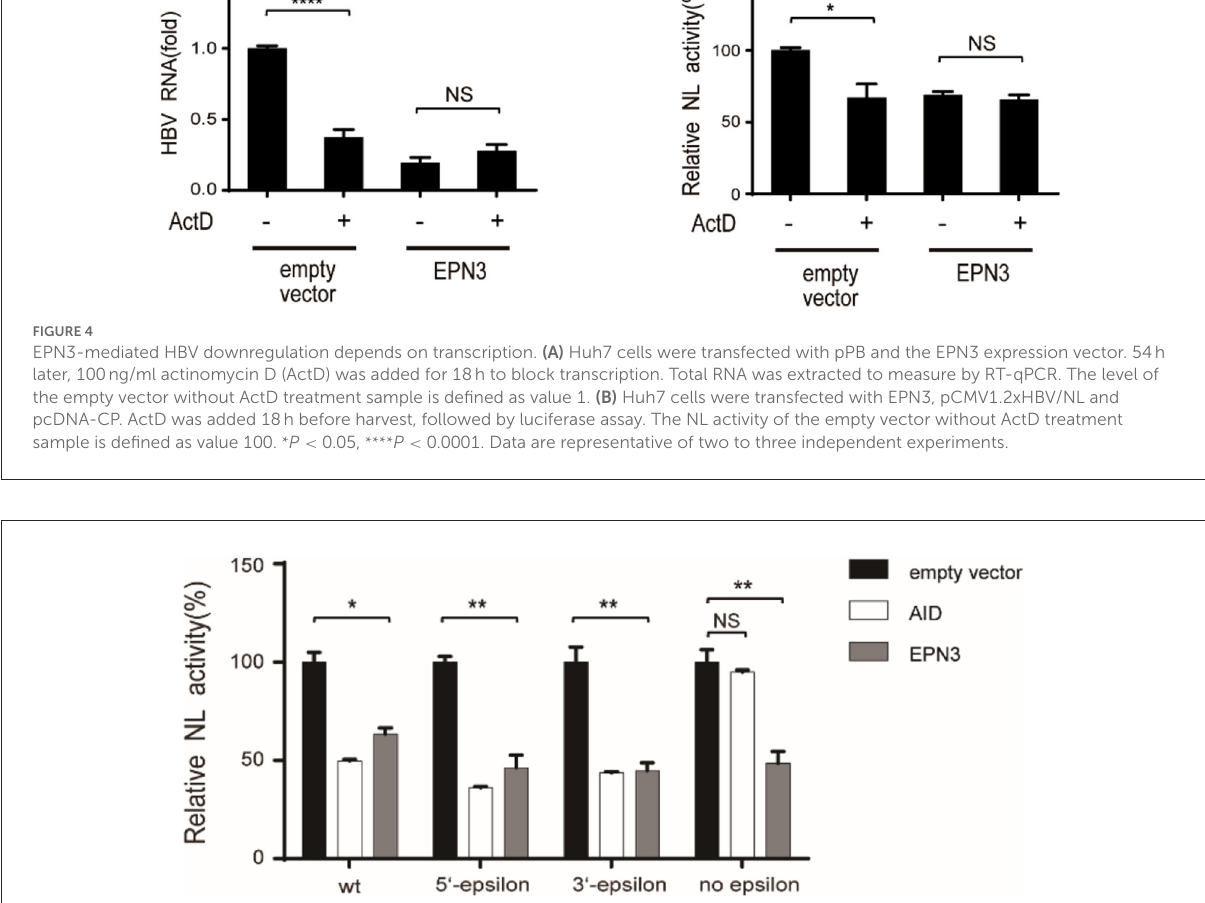
FIGURE5 EPN3 does not require epsilon structures for its anti-HBV effect. Huh7 cells were transfected with the wildtype or mutated pCMV1.2xHBV/NL (WT: wild type, 5 ′ -epsilon, 3 ′ -epsilon, or no epsilon), along with pcDNA-CP and either empty, AID, or EPN3 expression vector. Three days after transfection, cells were harvested and luciferase activity was determined. The NL activity of the empty vector transfectants defined as value 100. * P < 0.05, ** P < 0.01. Data are representative of two to three independent